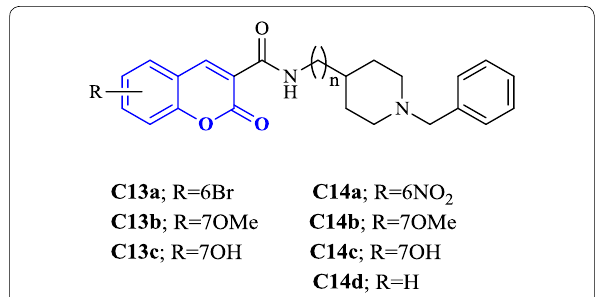
Fig. 18 Chemical structures of